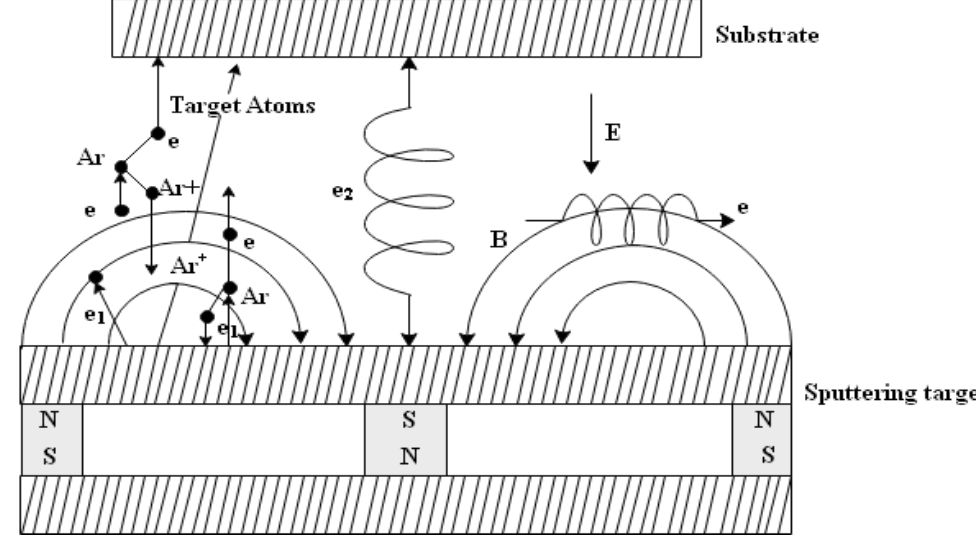
Figure 3. Schematic diagram of the magnetron sputtering principle [41].